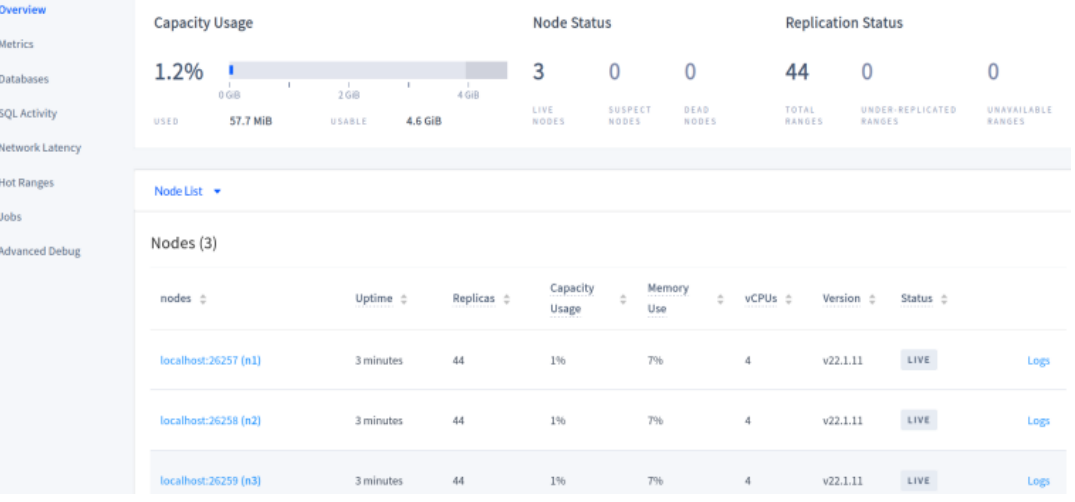
Figure 2. CockroachDB v21.2.10 web user interface cluster.